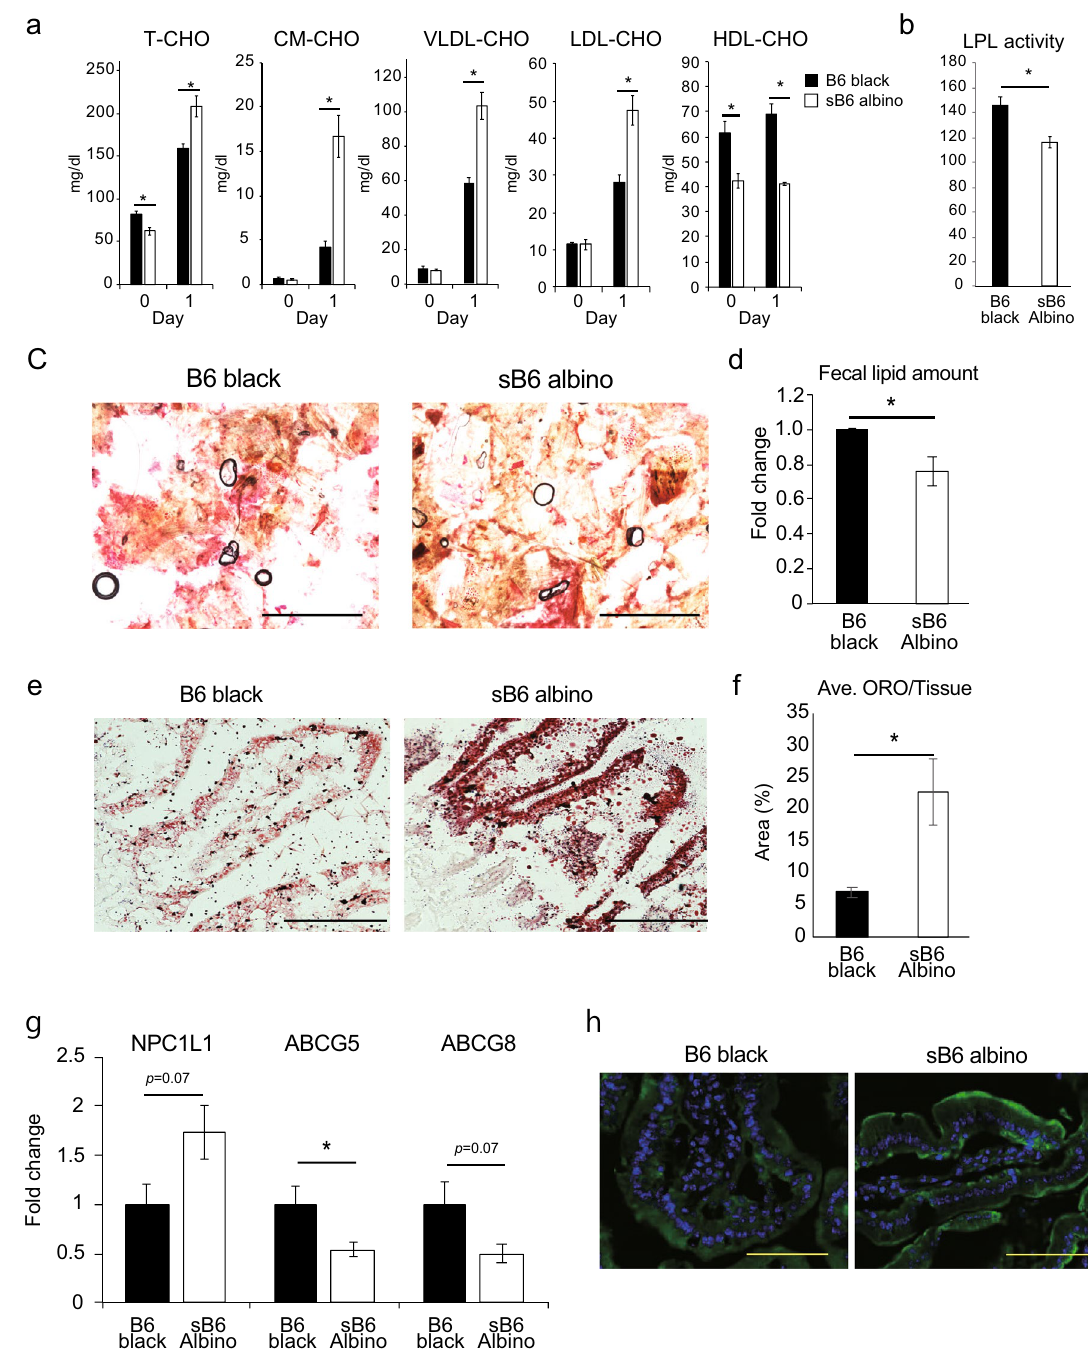
Figure 3. Severe B6 albino mice show impaired small intestinal cholesterol homeostasis. ( a ) Serum lipoprotein species before and 1-day after HCD feeding. T-CHO, CM-CHO, VLDL-CHO, LDL-CHO, and HDL-CHO are shown (B6 black n = 5, sB6 albino n = 5). ( b ) Serum LPL enzyme activity in sB6 albino (n = 3) and B6 black (n = 3) mice 1-day after cholesterol feeding. ( c ) Representative ORO staining of fecal matter from B6 black and B6 albino 1-day after HCD feeding (Scale bar = 1 mm). ( d ) Quantification of the lipid amount in feces normalized to B6 black amounts. Data from four independent experiments were pooled (B6 black n = 15, sB6 albino n = 18). ( e ) Representative view of ORO staining of SI 1.5 h after oral gavage with 2% cholesterol in 200 μl corn oil (Scale bar = 25 μm). ( f ) Quantification of ORO-positive area in intestinal tissue (B6 black n = 3, sB6 albino n = 3). ( g ) Relative expression of intestinal cholesterol transporter genes in HCD-fed B6 black and sB6 albino mice (B6 black n = 8, sB6 albino n = 11). Data were normalized using 36b4 mRNA levels. ( h ) Representative SI NPC1L1 staining (Scale bar = 100 μm). Data are from one representative experiment of at least two independent experiments and are presented as the means ± s.e.m. * p < 0.05 compared with B6 black (Welch’s